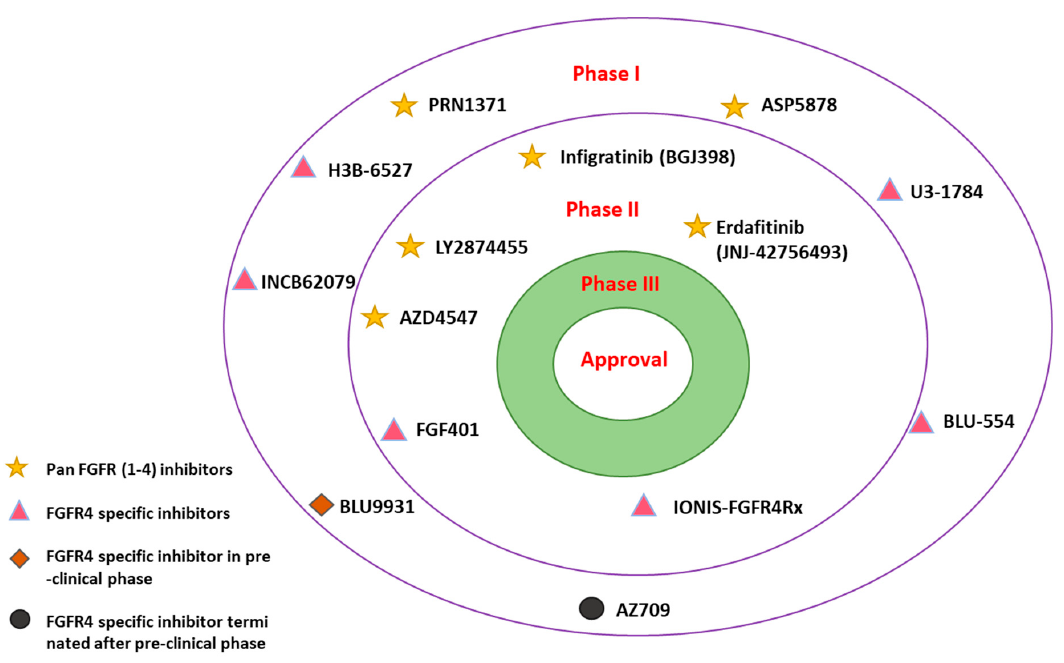
Figure 7. Selected overview of pan- FGFRs and FGFR4 -specific inhibitors in different stages of clinical trials for hepatocellular carcinoma (HCC).